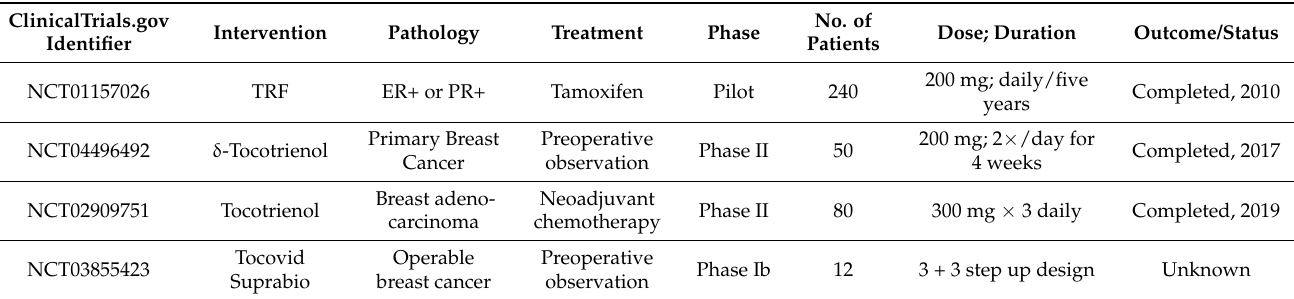
Table 2. All interventional clinical trials of tocotrienols in breast cancer patients [74–77]. Accessed 28 May 2021. ClinicalTrials.gov